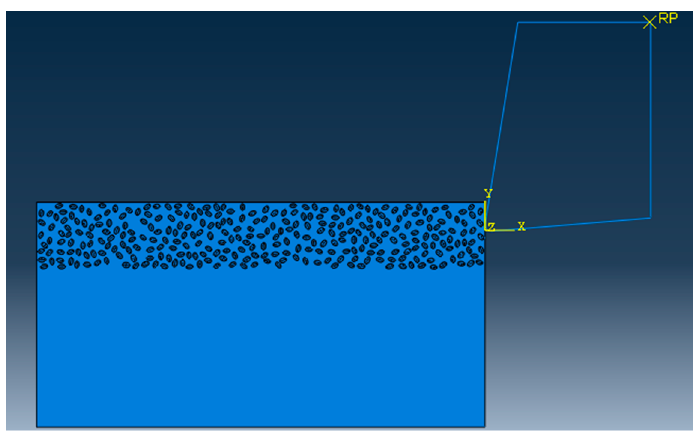
Figure 5. Two-dimensional orthogonal cutting finite element simulation models.